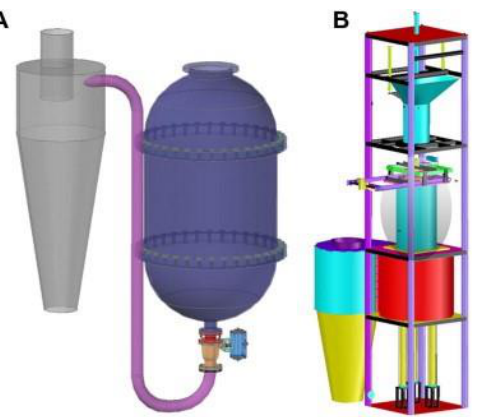
Figure 2. The structure diagram of two SE pretreatment models. ( A ) A model in valve blow mode. ( B ) A model in catapult explosion mode [43]. Reproduced with permission from Zhengdao Yu, Bailiang Zhang, Fuqiang Yu, Guizhuan Xu and Andong Song, Bioresource Technology; published by Elsevier, 2012.